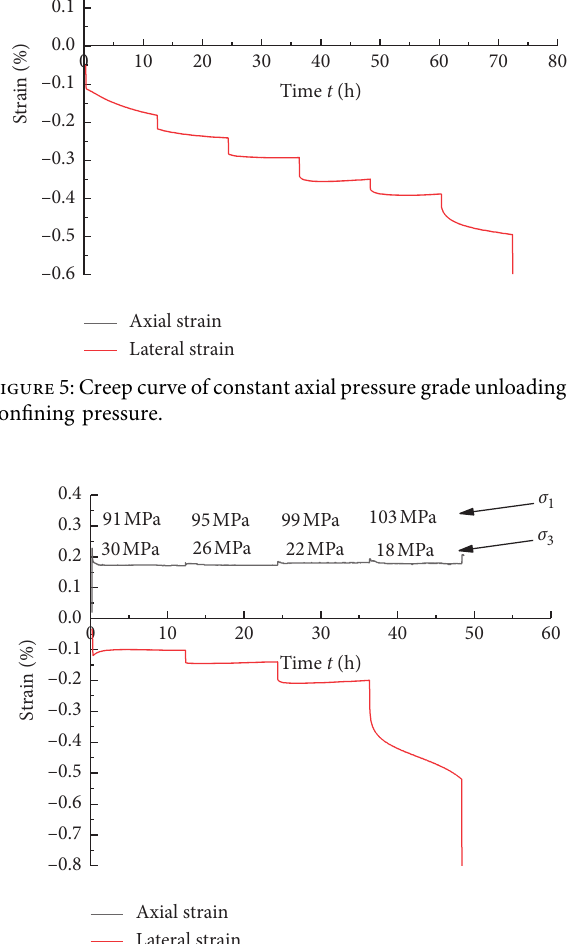
Figure 6: Creep curve of constant deviatoric stress grade unloading of confining